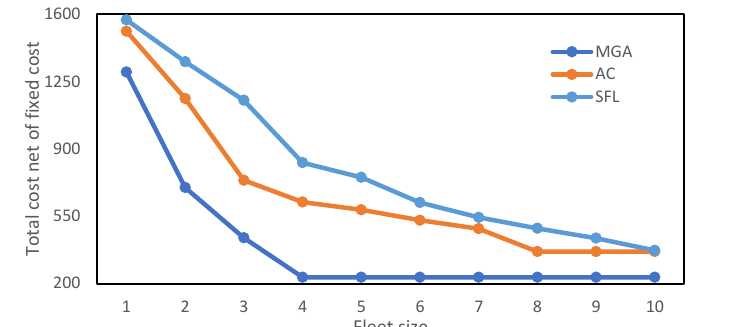
Figure 3. Total cost of different solutions.